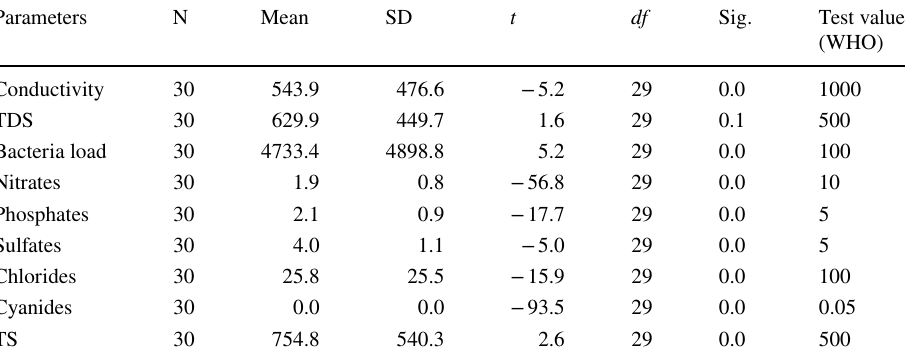
Table 8 Differences between the parameters and World Health Organization (WHO) limits. Source :